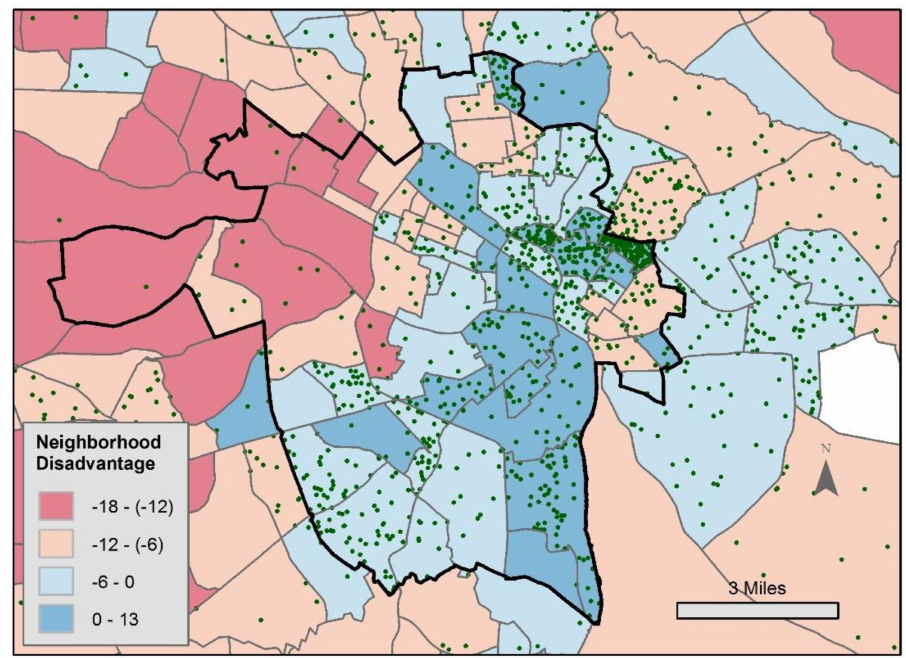
Figure 1. Map of the ecological momentary assessment (EMA) locations (green points) overlain on neighborhood disadvantage by census tract in the Richmond, Virginia area, where greater disadvantage is shown in blue. The city of Richmond is outlined in bold. The coordinate position of each EMA location is randomized within each tract for privacy protection. Note that some EMA locations occur outside the area of the